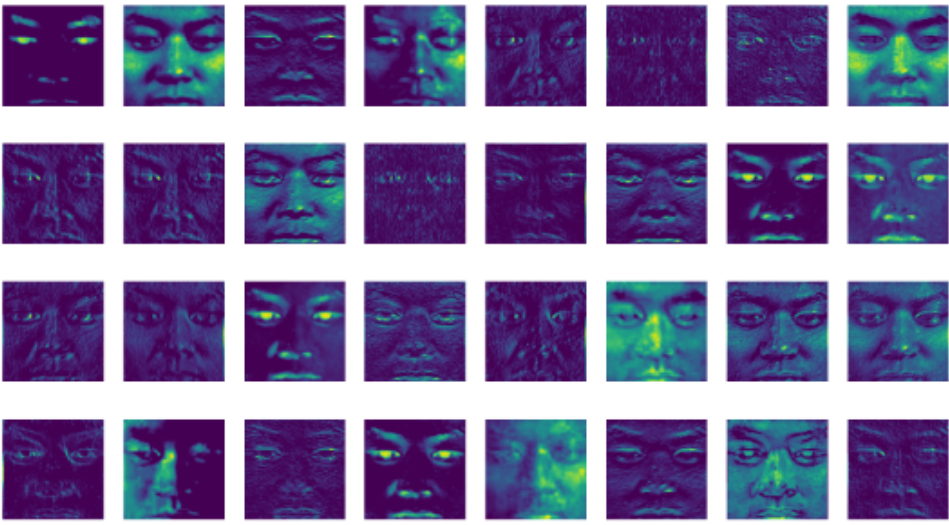
Figure 5. Attention ResNet-56 (Stage-2) hidden layer visualization of residual learning.